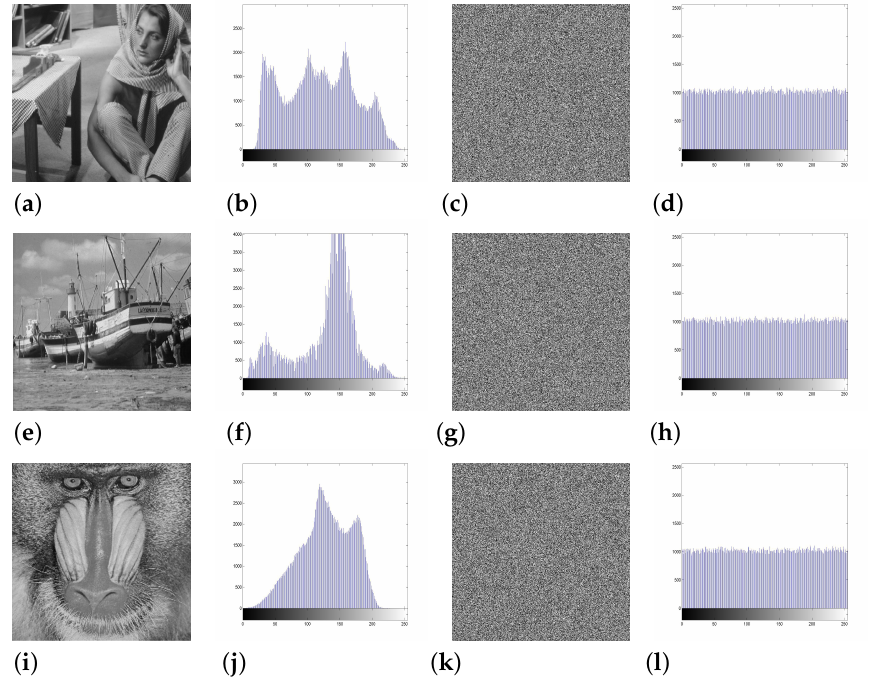
Figure 5. Histogram analysis: the plain images (( a ) Barbara ( 512 ( i ) Mandrill ( 512 512 ) ) and their corresponding histograms ( b , f , j ), the corresponding enciphered images × ( c , g , k ) and their corresponding histograms ( d , h , l ). Table 3. Entropy of enciphered images at c 0 = 1, c 1 =